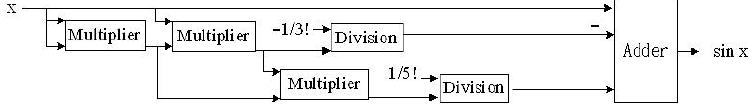
Figure 11. Block diagram of the sine function with the Taylor expansion.